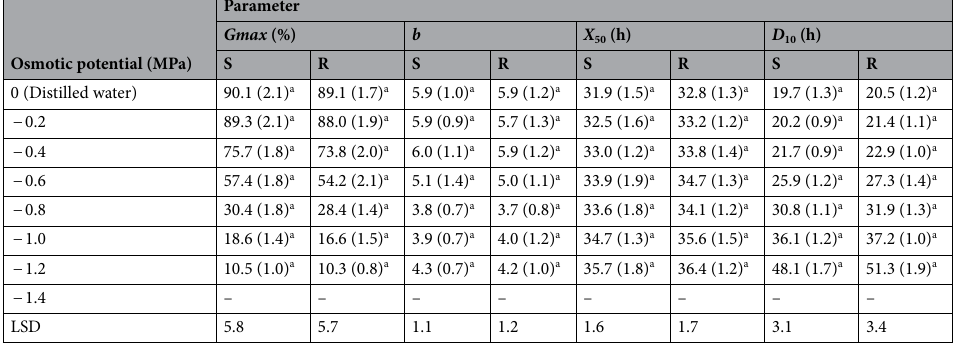
Osmotic potential